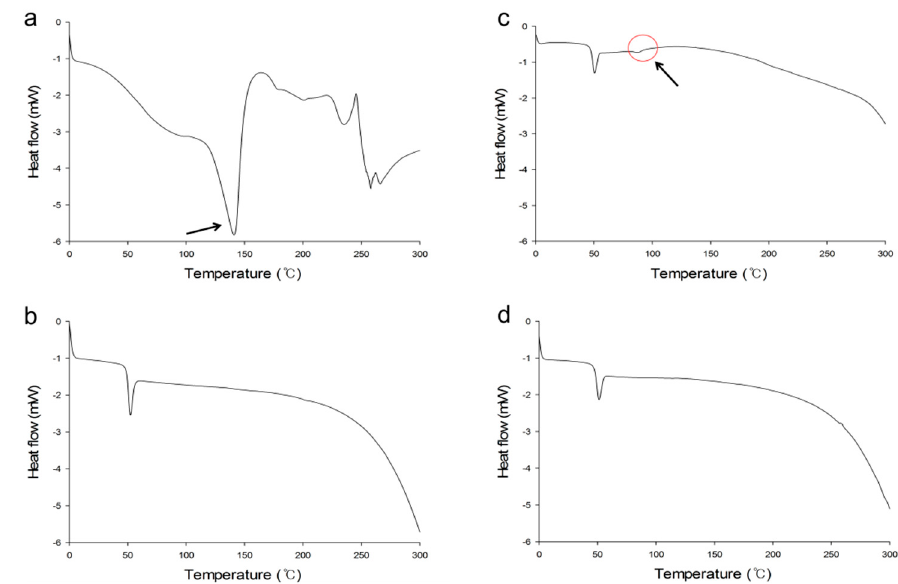
Figure 4. Differential scanning calorimetry (DSC) thermograms of MTX ( a ), PLGA ( b ), physical mixture of MTX/PLGA ( c ) and MTX-loaded PLGA NPs ( d ). ↖ : endothermic melting peak of MTX.